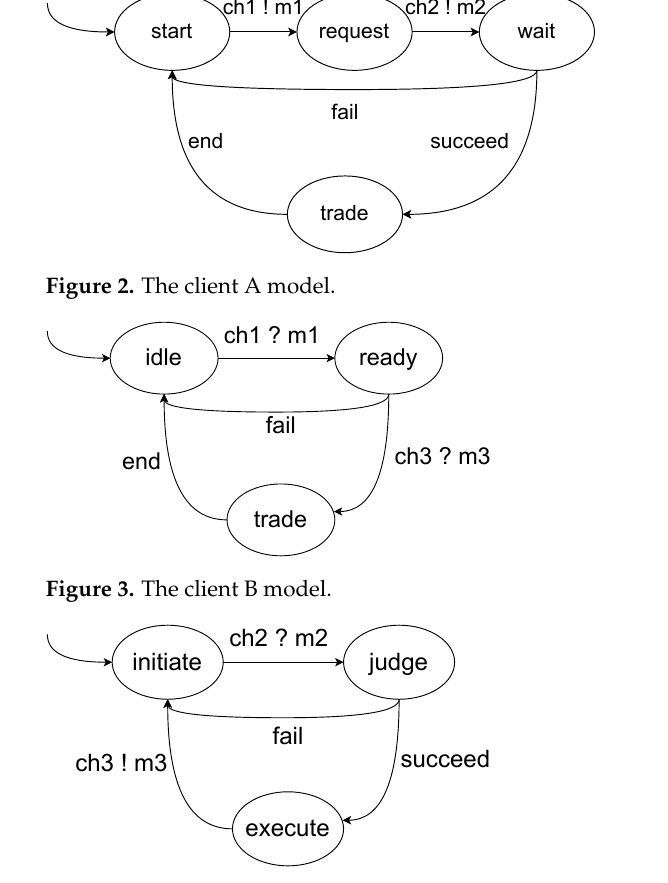
Figure 4. The smart contract